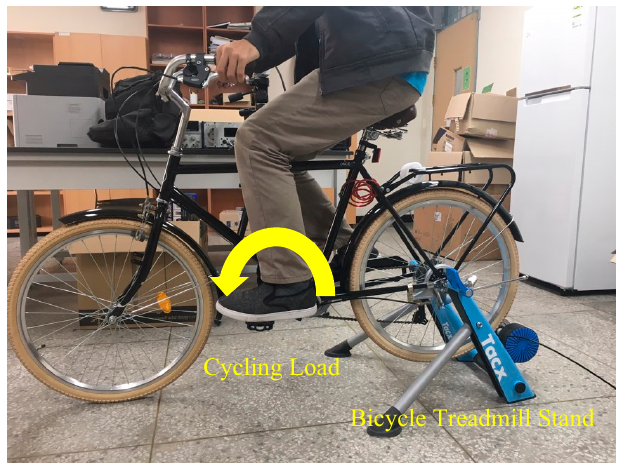
Figure 21. Dynamic load experiment. Figure 21 . Dynamic load experiment. Figure 21 . Dynamic load experiment.